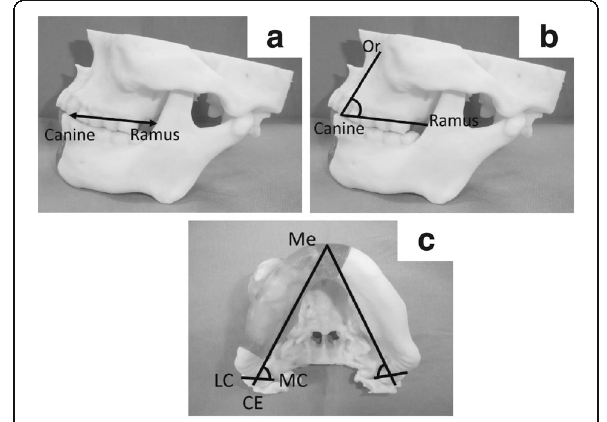
Fig. 2 a – c Measurements, length, and angle. a Length, ramus to maxillary canine, b Angle, Or-Canine-Ramus, c Angle, Me-CE and